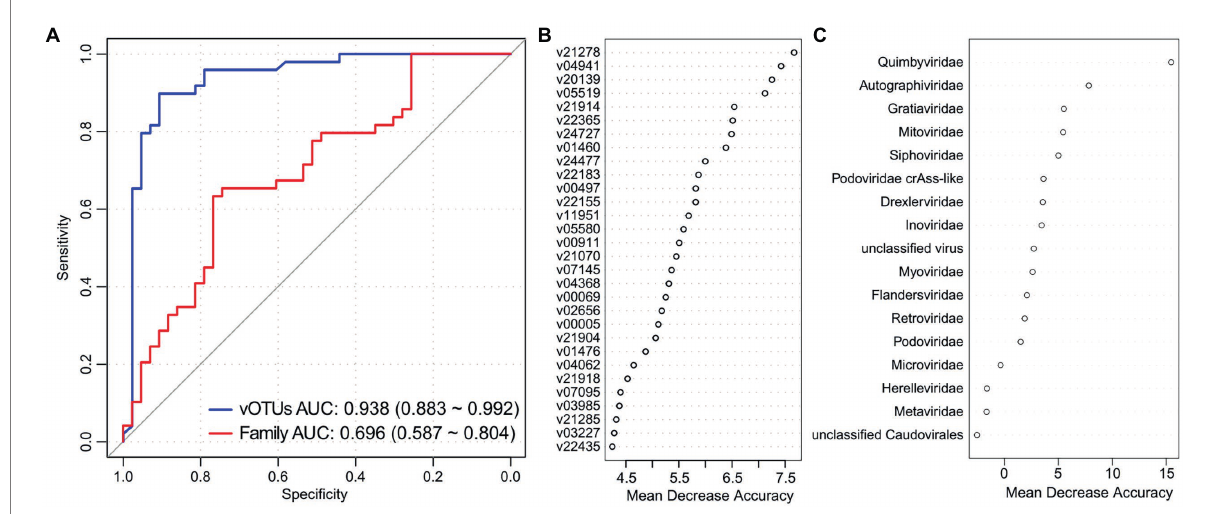
FIGURE 4 Gut virome-based classification of the PCOS patients and controls. (A) Random forest models for discriminating PCOS patients and healthy controls based on gut viral profiles at the vOTU and family levels. The AUC and 95% CI are shown. (B,C) Mean decrease in accuracy showing the contribution of the top 30 vOTUs (B) and all viral families (C) in the random forest